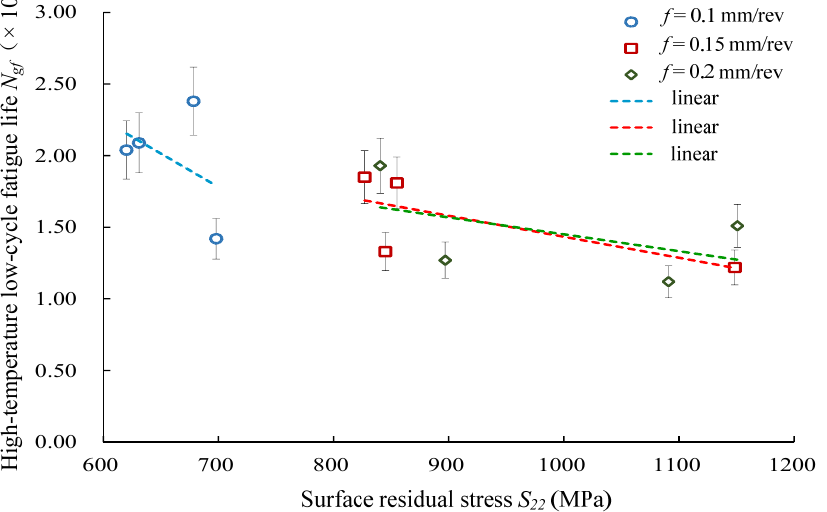
Figure 9. Effects of surface residual stress S 22 (cutting speed direction) on low-cycle fatigue life.